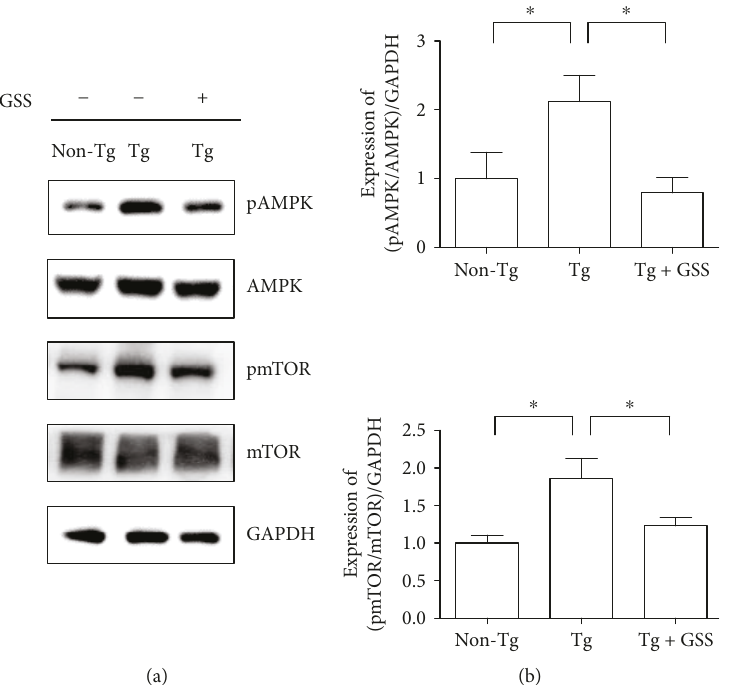
Figure 4: GSS modulates energy metabolism-related proteins in the spinal cord of hSOD1 G93A transgenic (Tg) mice. (a) Representative Western blots showing the expression of pAMPK, AMPK, pmTOR, and mTOR in the spinal cord of control (Non-Tg), hSOD1 G93A Tg, and GSS-treated Tg mice (Tg+ GSS) mice. GAPDH was used to control for protein loading. (b) Quanti fi cation of the ratio of pAMPK/ total AMPK and pmTOR/mTOR normalized to GAPDH. Data represent the means ± SEM ( n = 4 ) and were evaluated by one-way ANOVA and Newman-Keuls ’ post hoc test. ∗ p < 0 05